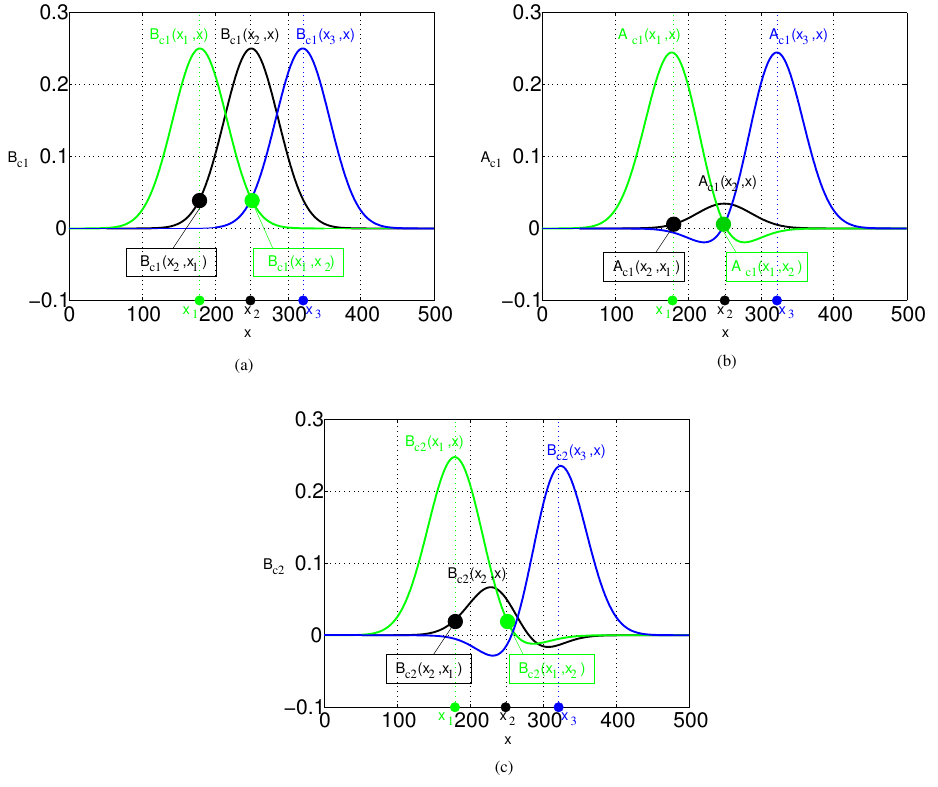
Fig. 14. (a) Initial background error covariances in B c1 , (b) analysis error covariances in A c1 after one analysis and (c) updated covariances in B c2 for points x 1 = 180 (green), x 2 = x obs = 250 (black) and x 3 = 320